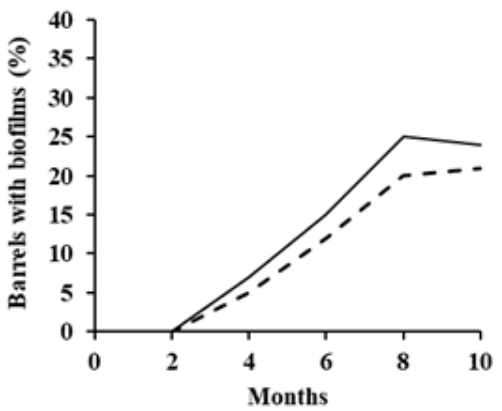
Figure 1. Dynamic of the yeast film contamination in the brine of black table olive stored in plastic barrels in an industrial processing plant ( ̶ , Leccino; —Taggiasca).